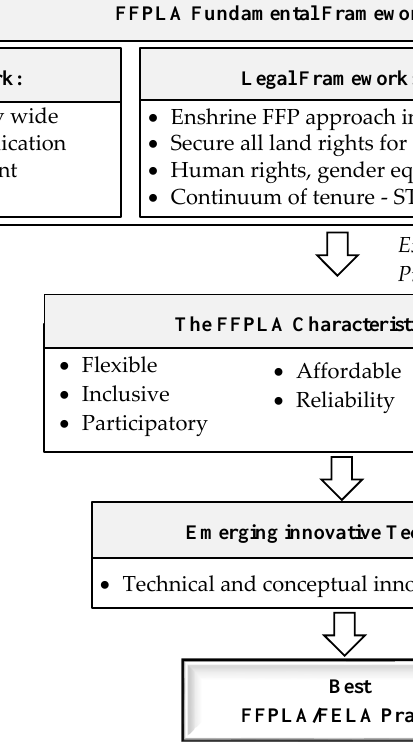
Figure 3. The research methodology .